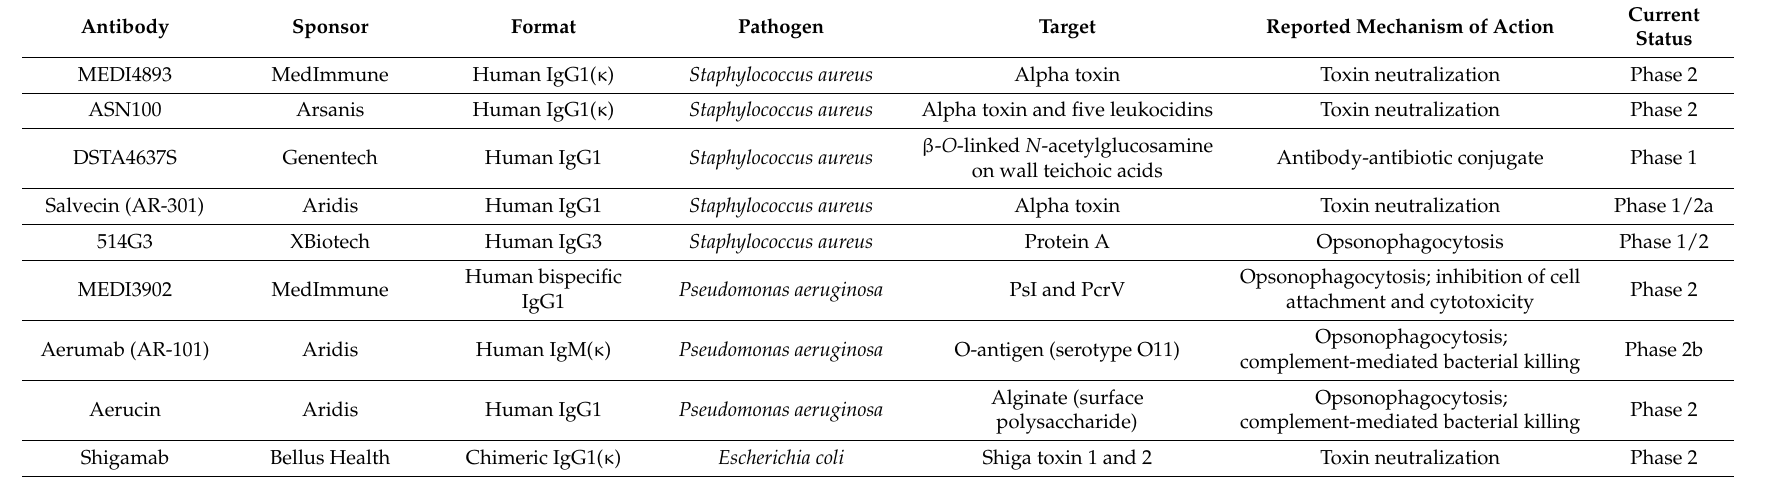
Table 2. mAbs currently in clinical